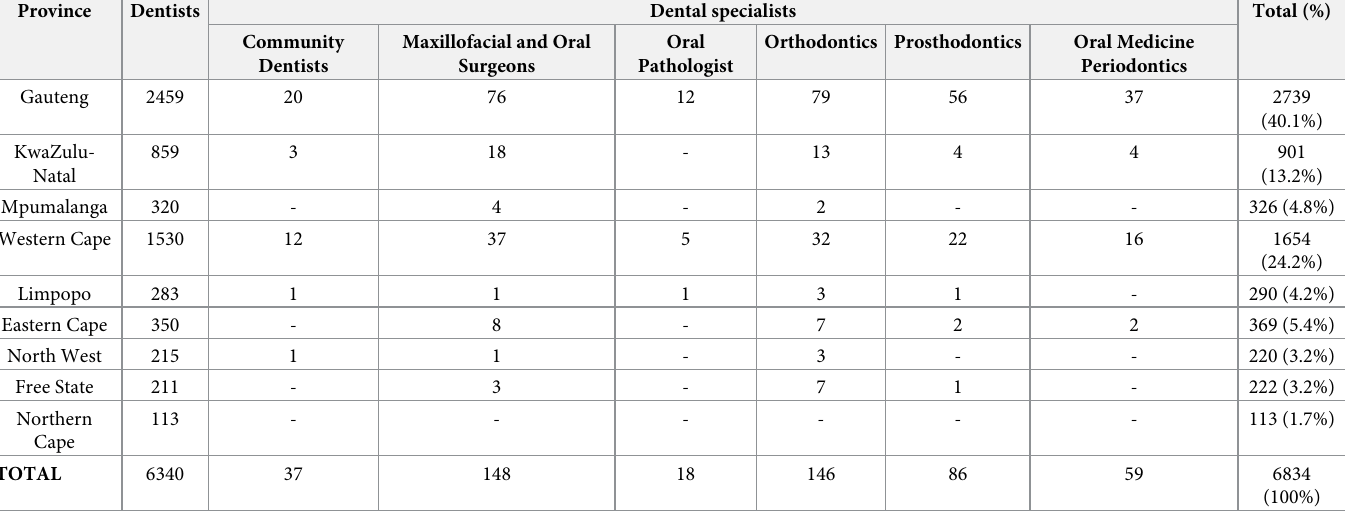
Table 2. Geographical distribution of dentists and dental specialists in SA (January